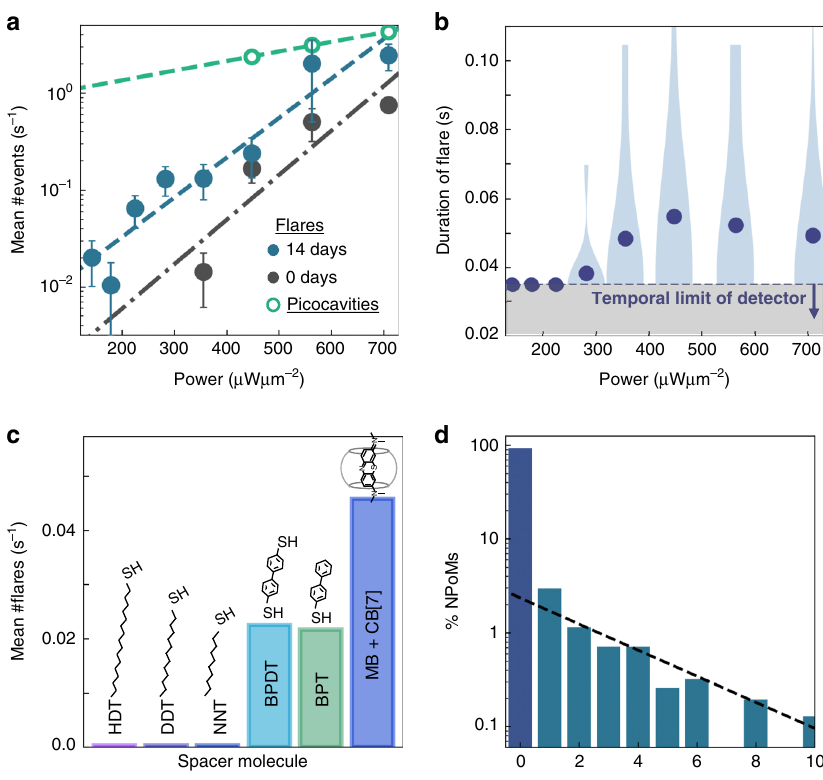
Fig. 4 Flare dependence on illumination and molecular spacer. a Mean fl ares per second vs. power, for NPoM samples immediately after self-assembly (black) or after 14 days in air at 300 K (blue), picocavities (green). Here 500 NPoMs are surveyed for each power, lines show exponential fi ts, error bars indicate standard deviations. b Flare durations vs. power, showing mean (points) and distributions (blue violin ranges), grey region shows temporal limit of detector. c Occurrence frequency of fl are events for different spacer molecules depicted. d Fraction of BPT NPoMs that show different numbers of fl ares, power 0.7 mW μ m − 2